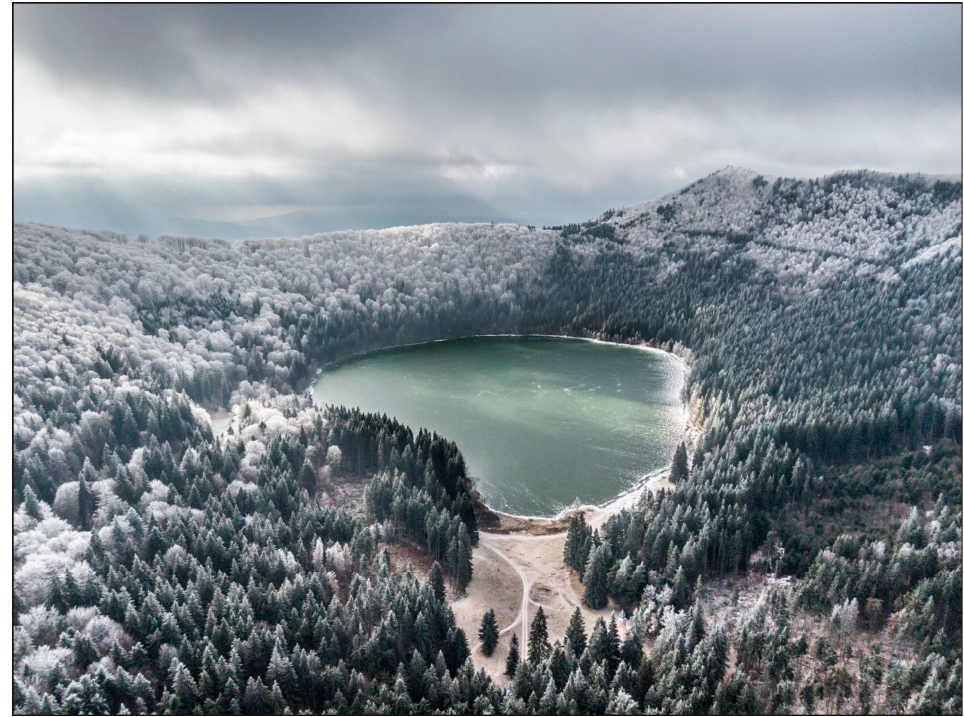
Figure 26. Spectacular drone-realized winter picture of the Sf. Ana crater and lake (Photo credit: Szilamér Huszár, National Geographic Hungary, 22 January 2022).